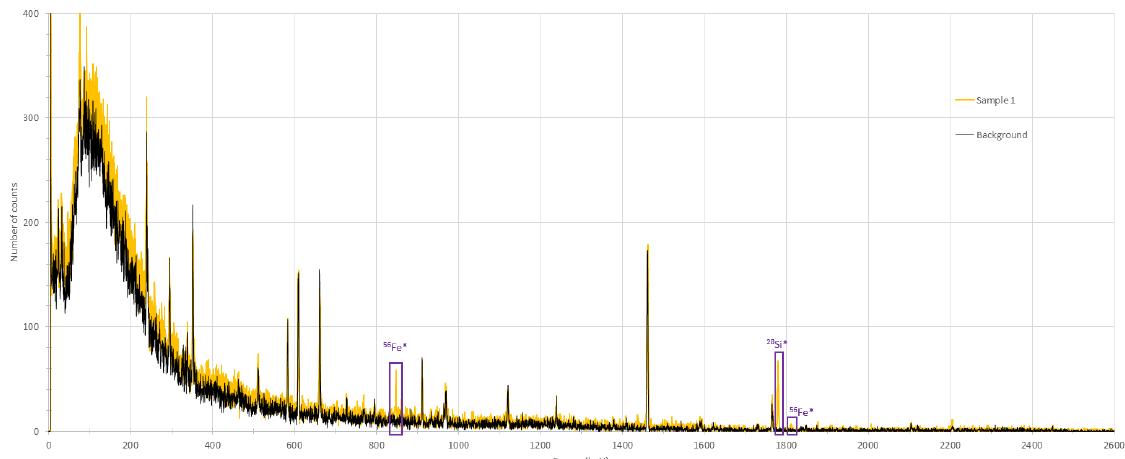
Fig. 4. Delayed gamma-ray spectrum of the background.